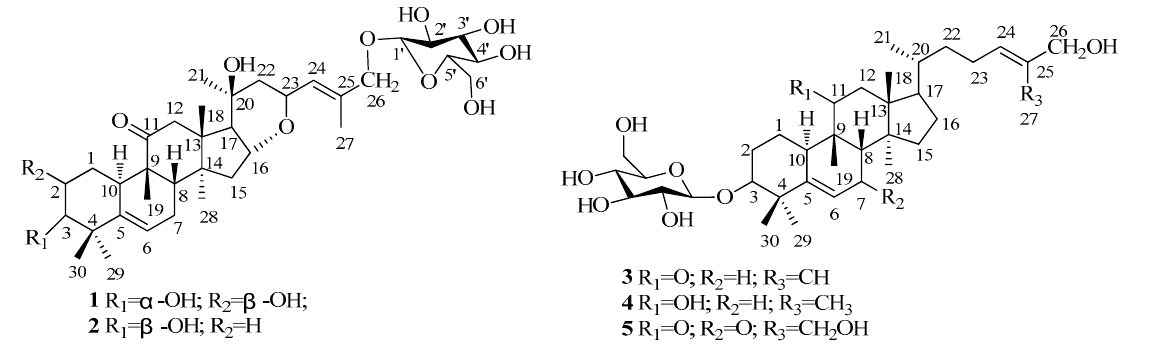
Figure 1. Structures of compounds 1 – 5 Figure 1. structures of compounds 1 – 5 .